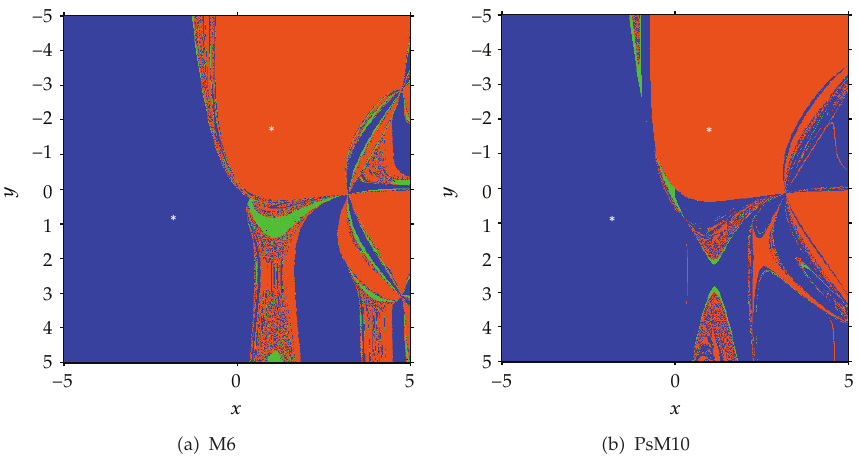
Figure 4: Real dynamical planes for system F 3 (cid:4) x (cid:5) (cid:6) 0 and methods M6 and